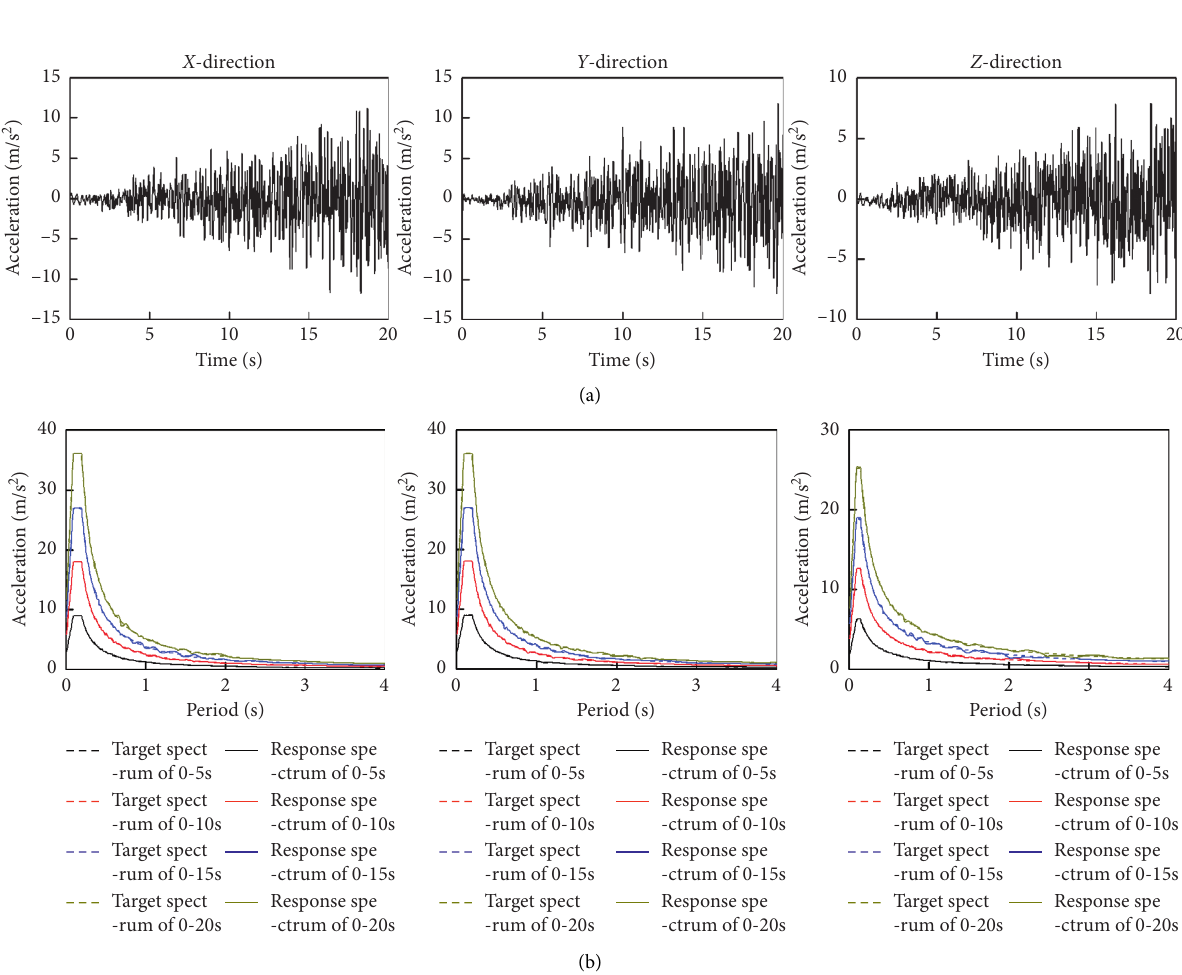
Figure 10: Typical (a) ETAHs and (b) acceleration response spectra within different interval